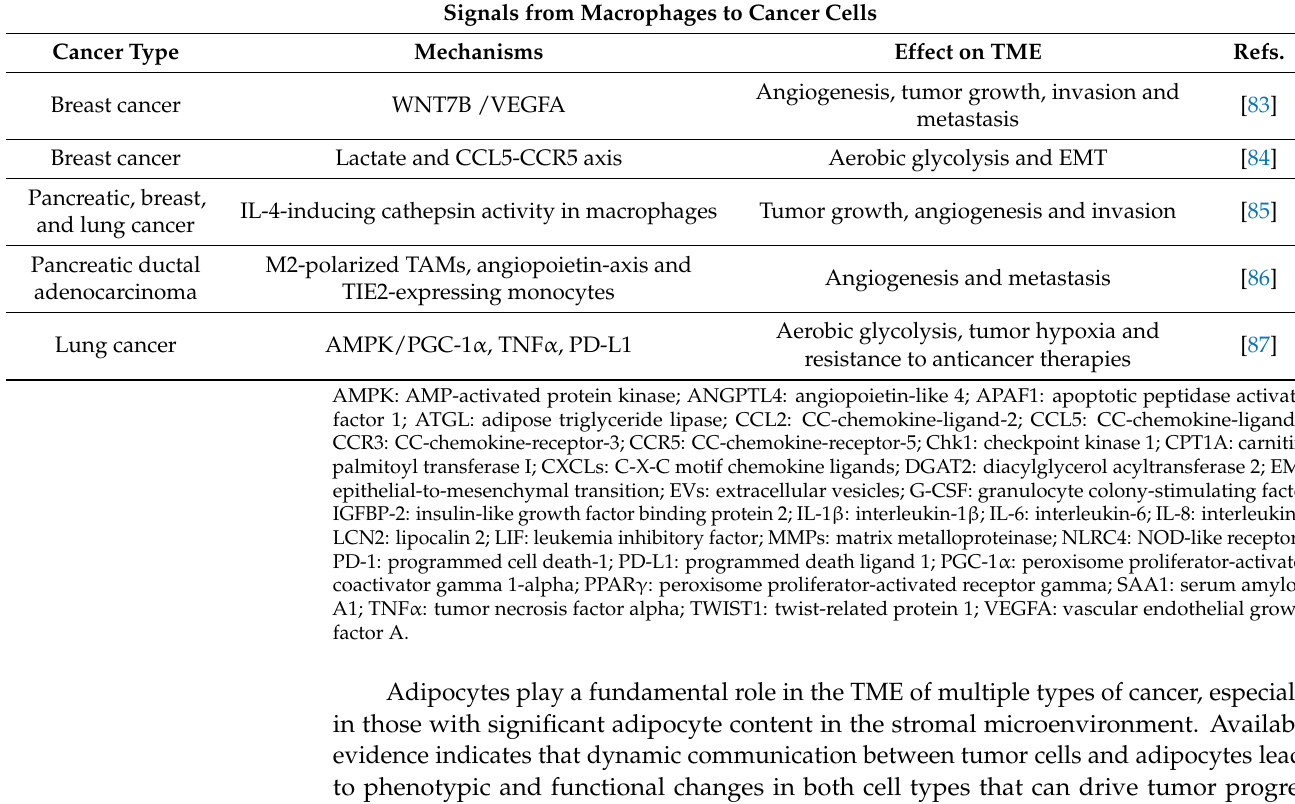
Table 2. Cont. Signals from Macrophages to Cancer